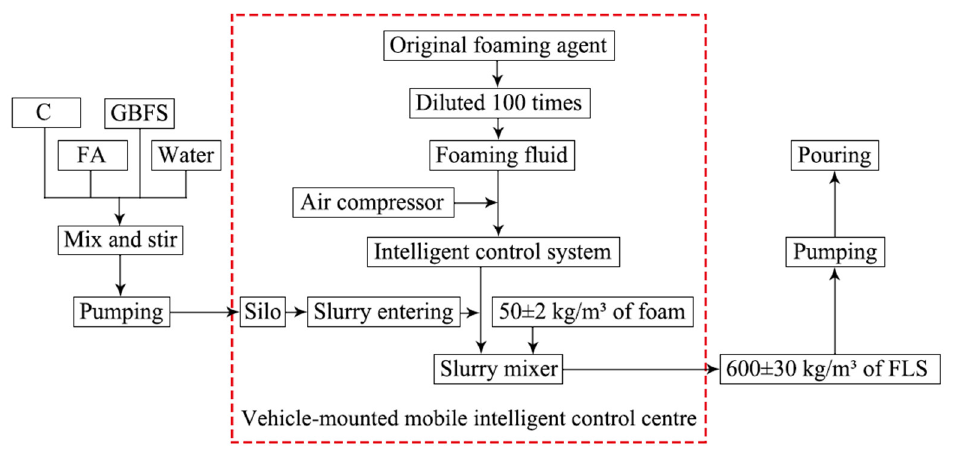
Figure 5. Process flow diagram for preparation of FLS.